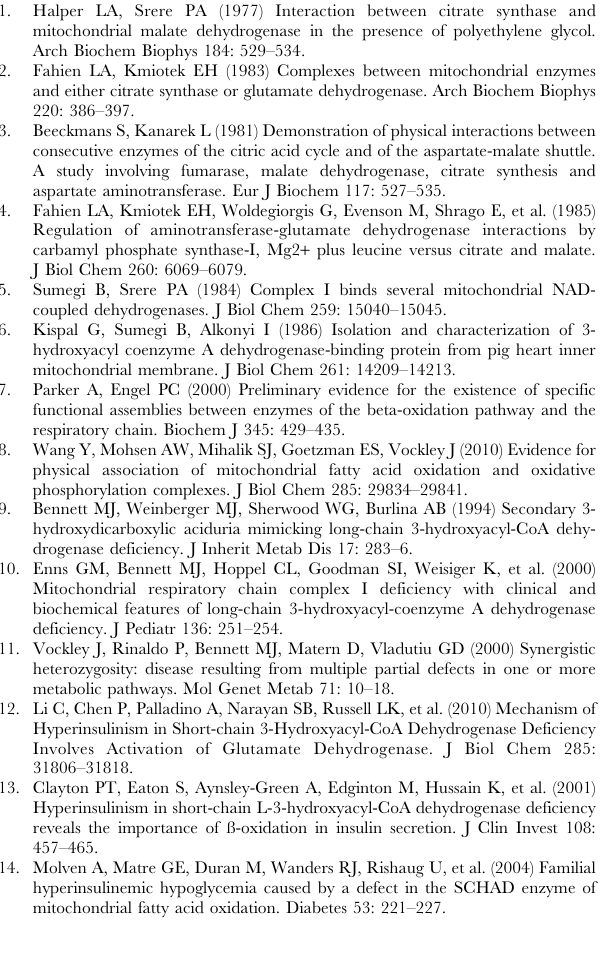
Table S3 Full pulldown proteomic details from wild type and SCHAD knockout heart. Table S4 Full pulldown proteomic details from wild type and SCHAD knockout skeletal muscle. Table S5 Full pulldown proteomic details from wild type and SCHAD knockout